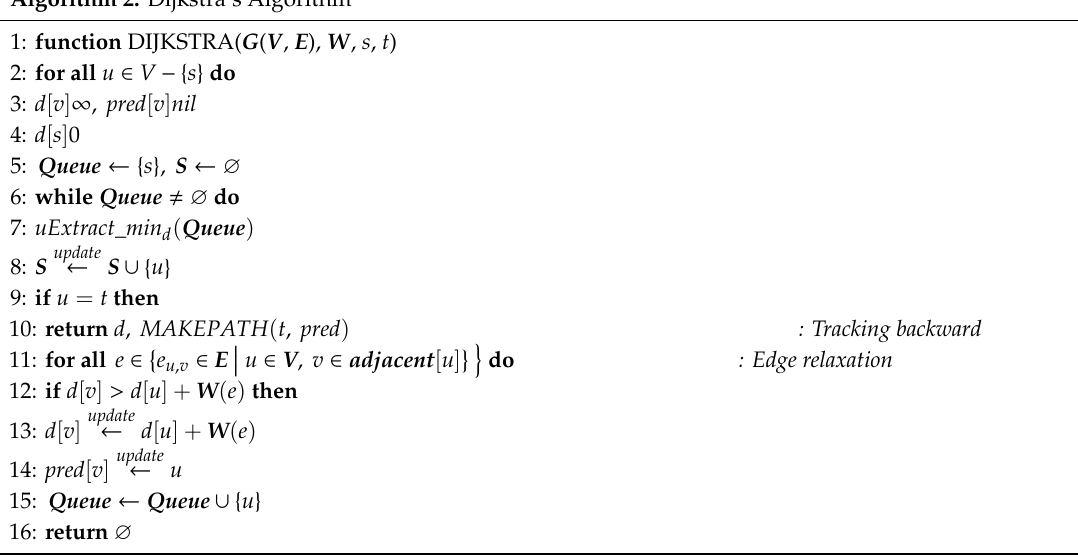
Algorithm 2. Dijkstra’s